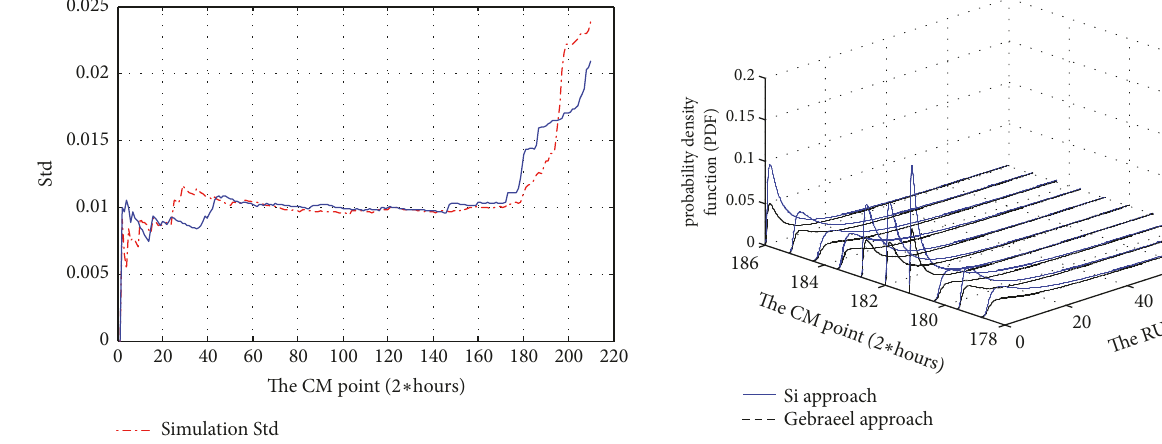
Figure 11: Illustration of the RUL distributions at last 8 CM